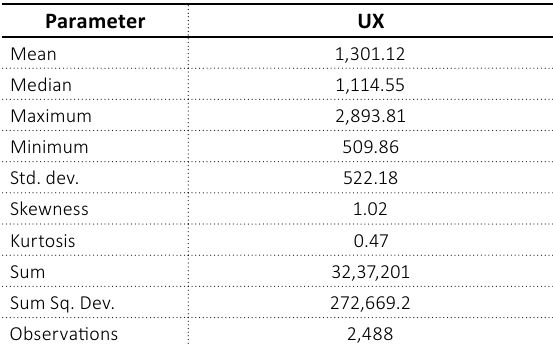
Table 1. Descriptive statistics for data, UX index over the period from 2009 to